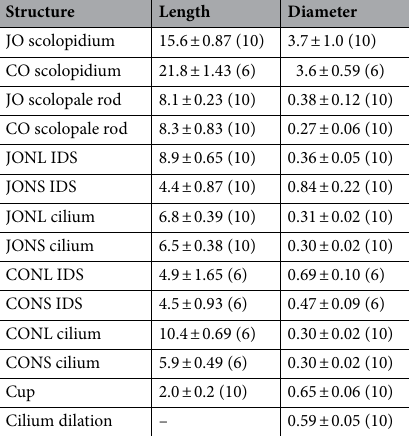
Table 1. Dimensions of cells and cellular structures of female Megaphragma viggianii chordotonal organs (Johnston’s organ (JO) and central organ (CO)); mean ± SD (n), µm. JONL—long JO neurons, JONS—short JO neurons, CONS—short CO neurons, CONL—long CO neurons, IDS—inner dendritic segment.